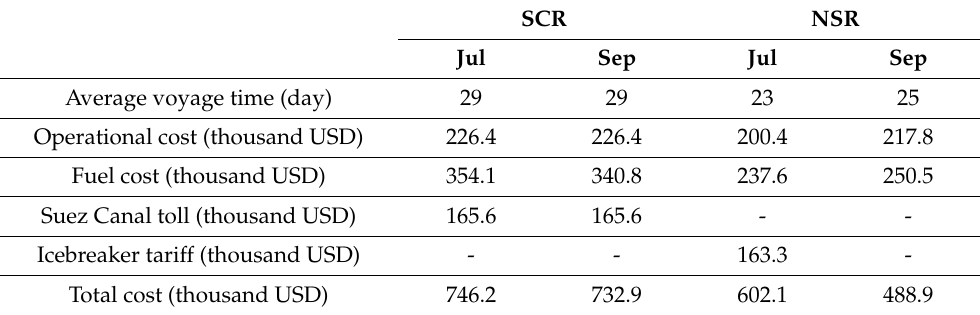
Table 10. Total costs per voyage in thousand